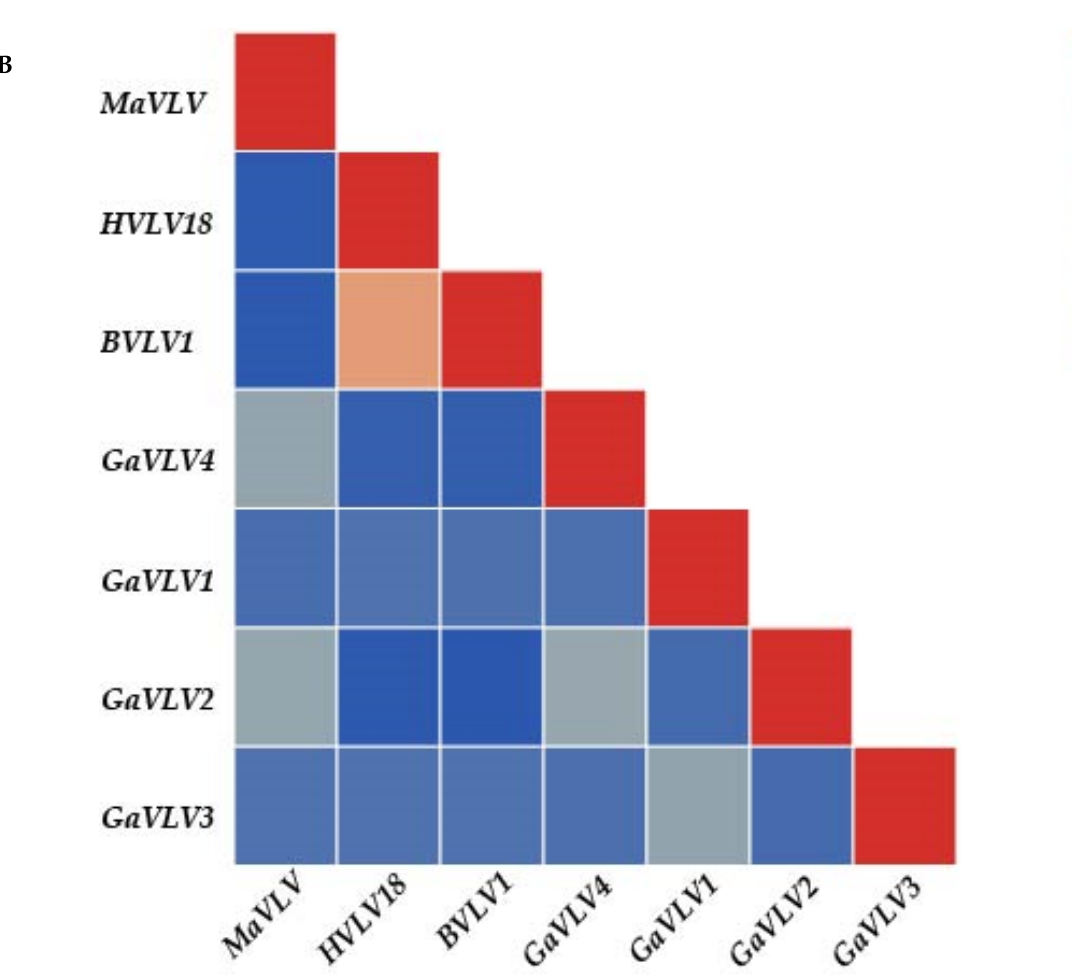
Figure 3. Phylogenetic trees of ( A ) RdRp proteins constructed for representative members of the family Virgaviridae ( 40 tobamoviruses; 5 furoviruses; 6 pomoviruses; 2 pecluviruses; 3 tobraviruses and 32 unclassified virgaviridaes). ( B ) The pairwise identity plots of the RNA-dependent RNA polymerase amino acid sequences aligned by ClustalW and displayed by sequence demarcation using TBtools software. The trees were constructed using the maximum likelihood method, and the statistical significance of the branches was evaluated by bootstrap analysis (1000 replicates). Newly discovered viruses are marked in red. 40 tobamovirus are collapsed together. Relationship: pink background.